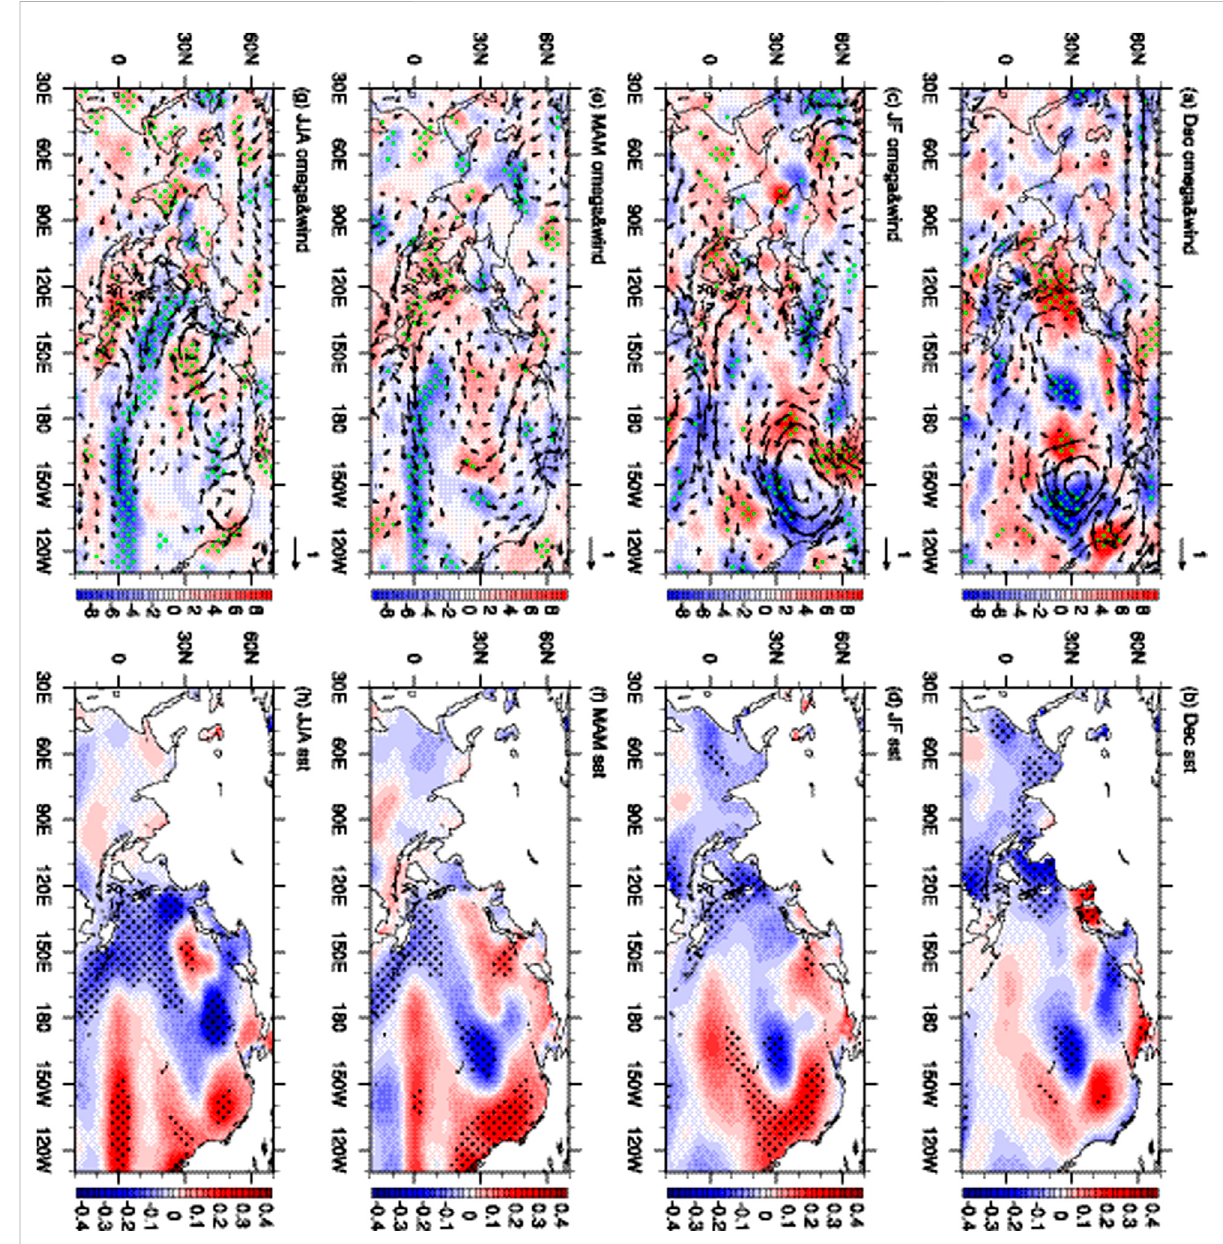
FIGURE 8 Anomalies of (A,C,E,G) the500 hPa verticalvelocity(shading;units:10 – 3 Pa s − 1 )and850 hPa horizontalwind(vector;units:m s − 1 )and (B,D,F,H) the SST (units: K) in the simultaneous (A,B) December, the following (C,D) January − February mean, (E,F) March − April − May mean and (G,H) summer regressed on the time series of the sign-reversed soil_Dec with the linear signal of Nino3.4 in December removed. The dots denote the anomalies signi fi cant at the 90% con fi dence level based on Student ’ s t -test. Only the anomalies of the 850 hPa wind exceeding 0.1 m s − 1 are